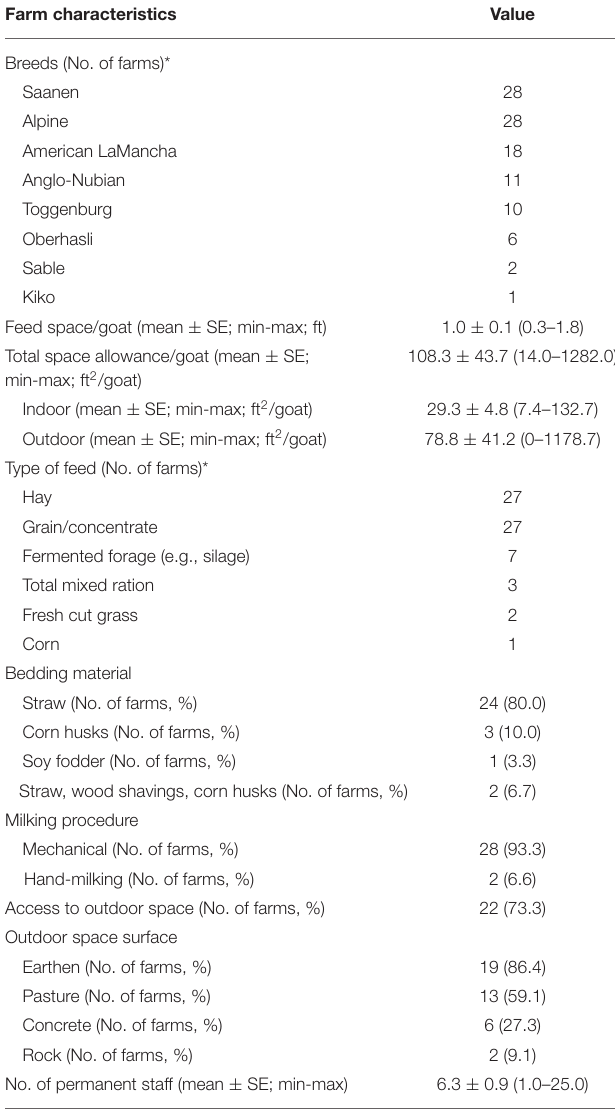
TABLE 4 | Characteristics of 30 dairy goat farms in the Midwestern United States. Farm